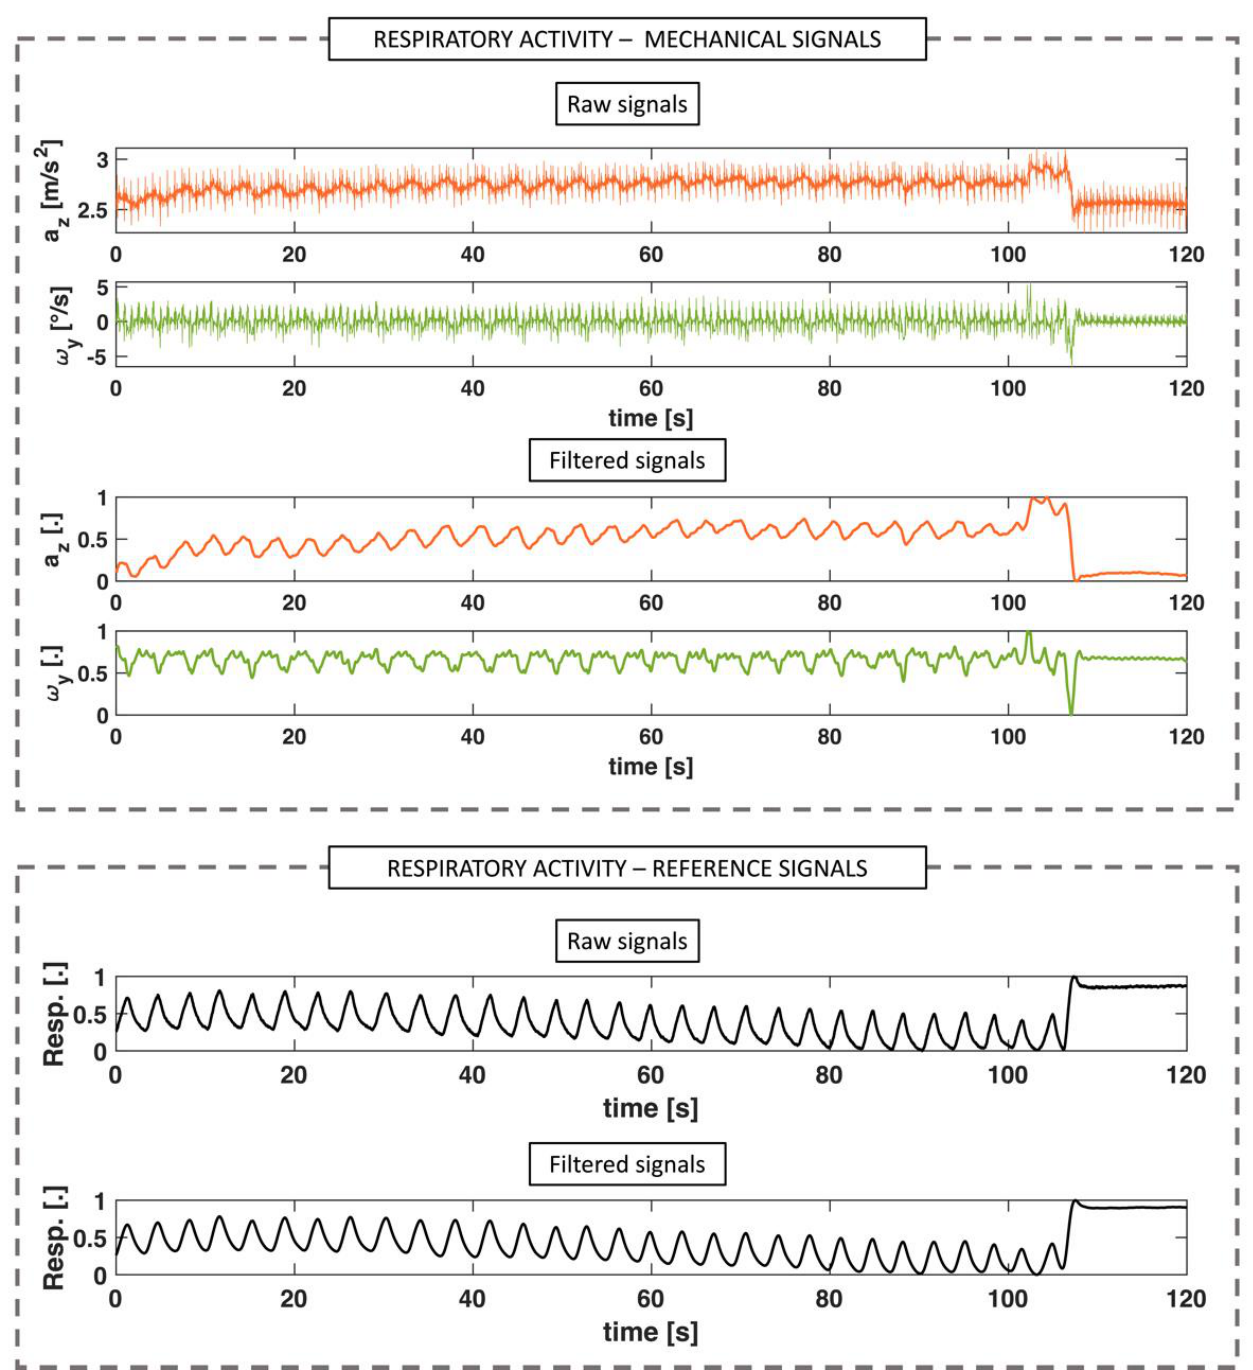
Figure 4. Signal processing for respiratory activity extraction for mechanical signals (i.e., accelerations, a and angular velocities, ω ) and reference respiratory waveform.